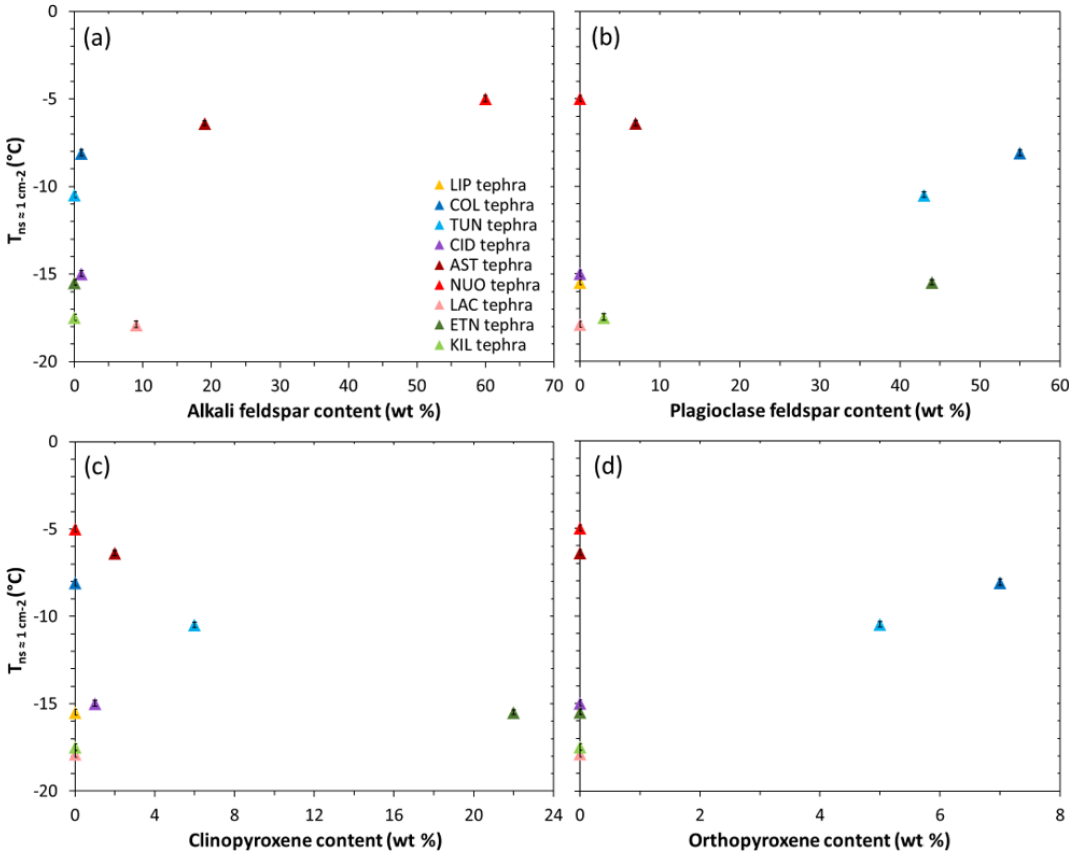
Figure 4. The INA ( T n − 2 ) of the tephra versus their content of (a) alkali feldspar, (b) plagioclase feldspar, (c) clinopyroxene, and s ≈ 1cm (d) orthopyroxene. Note that minor components below the XRD quantification limit are plotted at 1wt%. Ice nucleation experiments were conducted with 1wt% suspensions of tephra in water. The uncertainty in T n − 2 is shown as error bars (note that these are as small as s ≈ 1cm the data symbols). Sample codes are listed in Table